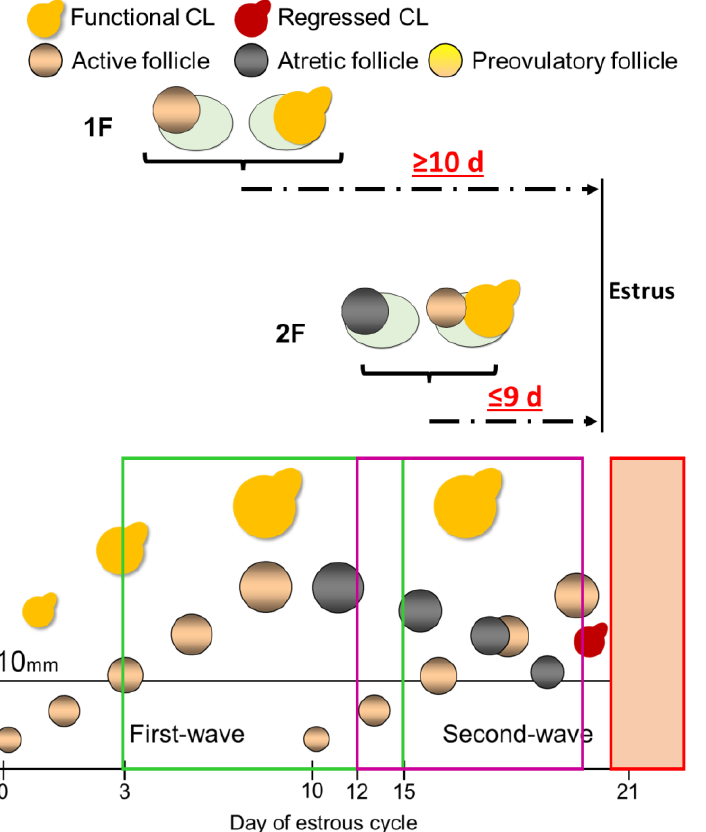
Figure 5. Schematic diagram of a simplified model of the mechanism of estrus expression timing based on the results of the present study. The majority of the cows during the early estrous cycle (from 3 to 12 days after estrus) had only one large follicle, which was composed of the physiologically active first-wave DF, and their majority during the late estrous cycle (15 days after estrus) had two or more large follicles, which were composed of the atretic first-wave DF and the physiologically active second-wave DF. Therefore, the majority of the cows with one large follicle, which were in an early estrous cycle, expressed estrus after 10 days from the ovarian examination. In contrast, the majority of the cows with two or more large follicles, which were in a later estrous cycle, expressed estrus within 9 days of the ovarian examination. Here, 1F = cows with one large follicle at the ovarian examination, n = 168; 2F = cows with two or more large follicles at the ovarian examination. A large follicle was defined as having a diameter of ≥10 mm.